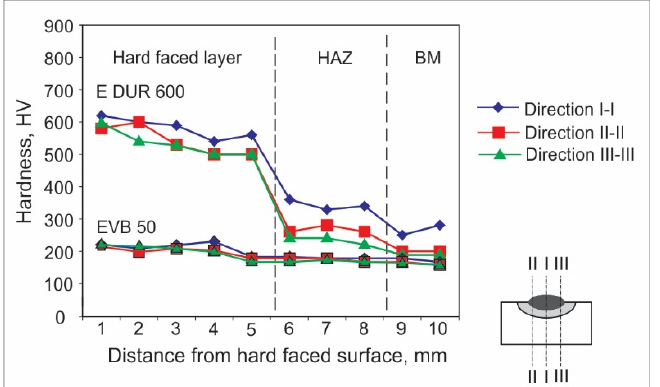
Figure 2. Hardness distribution in the hard-faced layer cross-section, BM-S355J2G3, FM-E DUR 600.